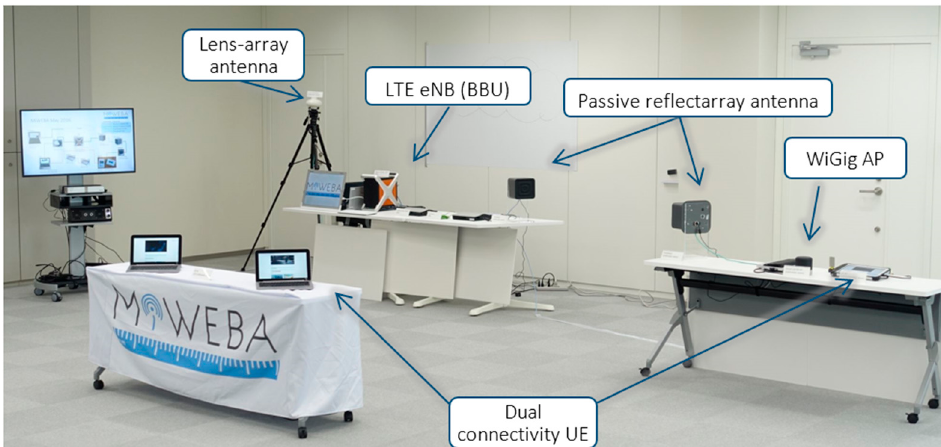
Figure 11. Hardware set-up of HetNet PoC.